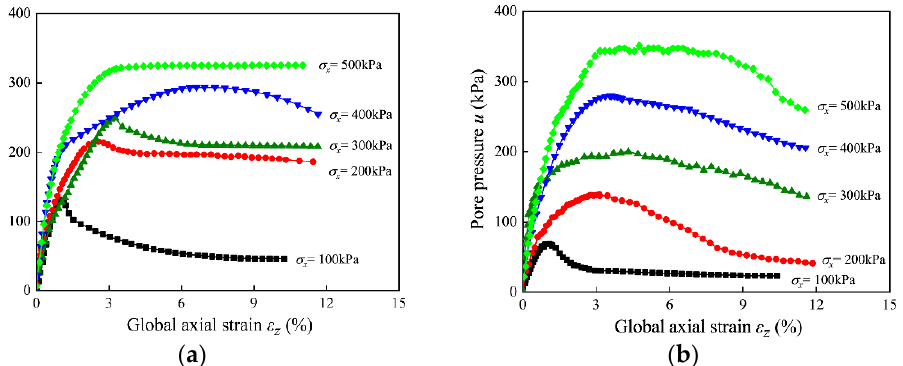
Figure 6. Global stress – strain and pore water pressure behavior for plane strain compression tests: ( a ) deviatoric stress ( σ z – σ x ) — axial strain ( ε z ) curves; ( b ) pore water pressure ( u ) – axial strain ( ε z ) curves.